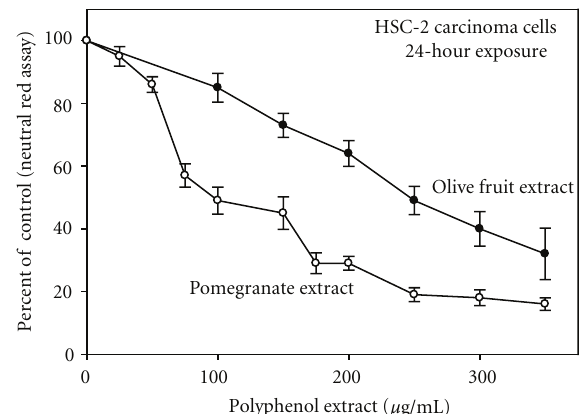
Figure 1: Comparative toxicities of pomegranate extract and olive fruit extract towards proliferation of human oral HSC-2 carcinoma cells as quantified with the neutral red assay, a cell viability assay. Data are presented as the mean percent of control ± S.E.M. Data for the pomegranate study are from Weisburg et al. [14] and for the olive fruit extract from Schuck